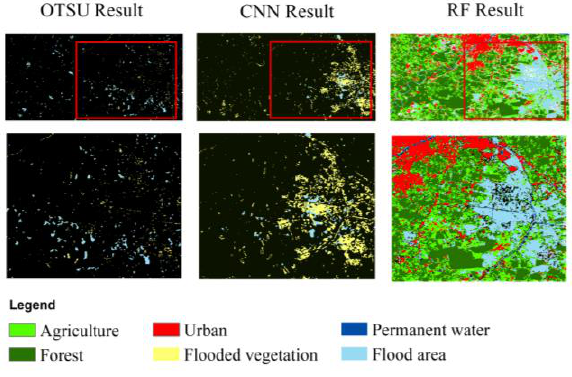
Figure 8 . OTSU, CNN and the RF results of Terme, Ordu.